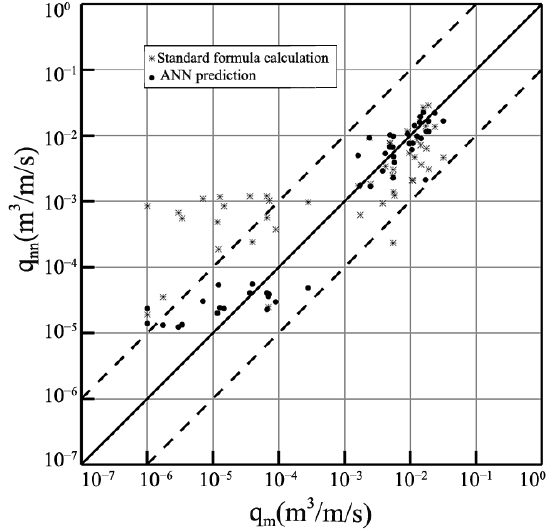
Figure 10. Comparing the estimated value of the ANN model, the Chinese standard formula, and the experiment.